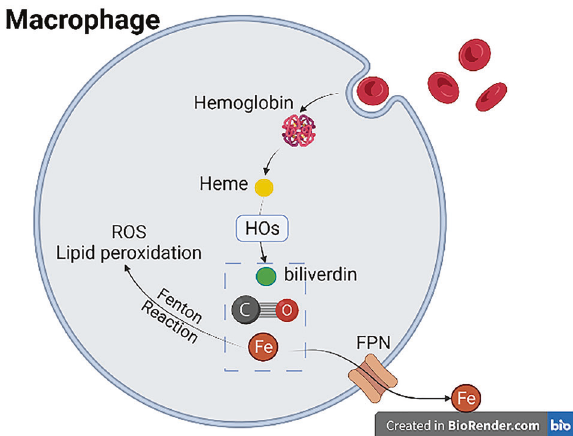
Fig. 7 Macrophages digest RBCs and raise iron level. Macrophages engulf RBCs and digest them into hemoglobin, which further